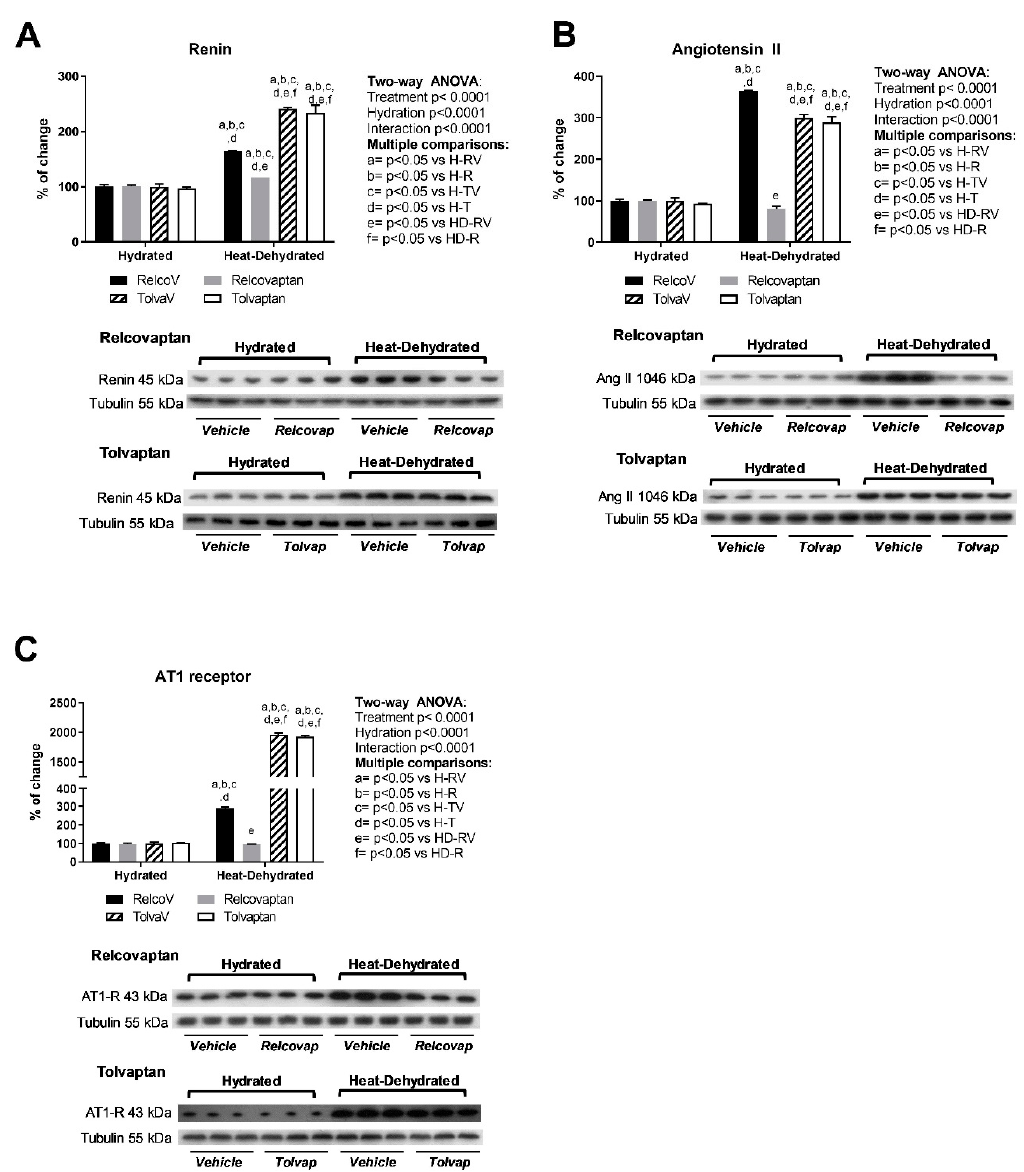
Figure 4. Effects of relcovaptan on the renin–angiotensin system. Heat stress and rehydration with a fructose-containing beverage induced the overexpression of renin ( A ), angiotensin II ( B ), and AT1 receptor ( C ). Tolvaptan prevented such effects. For western blotting, three random samples per group were selected. Proteins of interest and the respective loading controls were run independently at the same time using the same conditions. The raw dataset is available in the Supplementary Materials. 2.6. Relcovaptan Prevented the Overexpression of Glucocorticoid-Inducible Kinase 1 (SGK1) in Heat Stress-